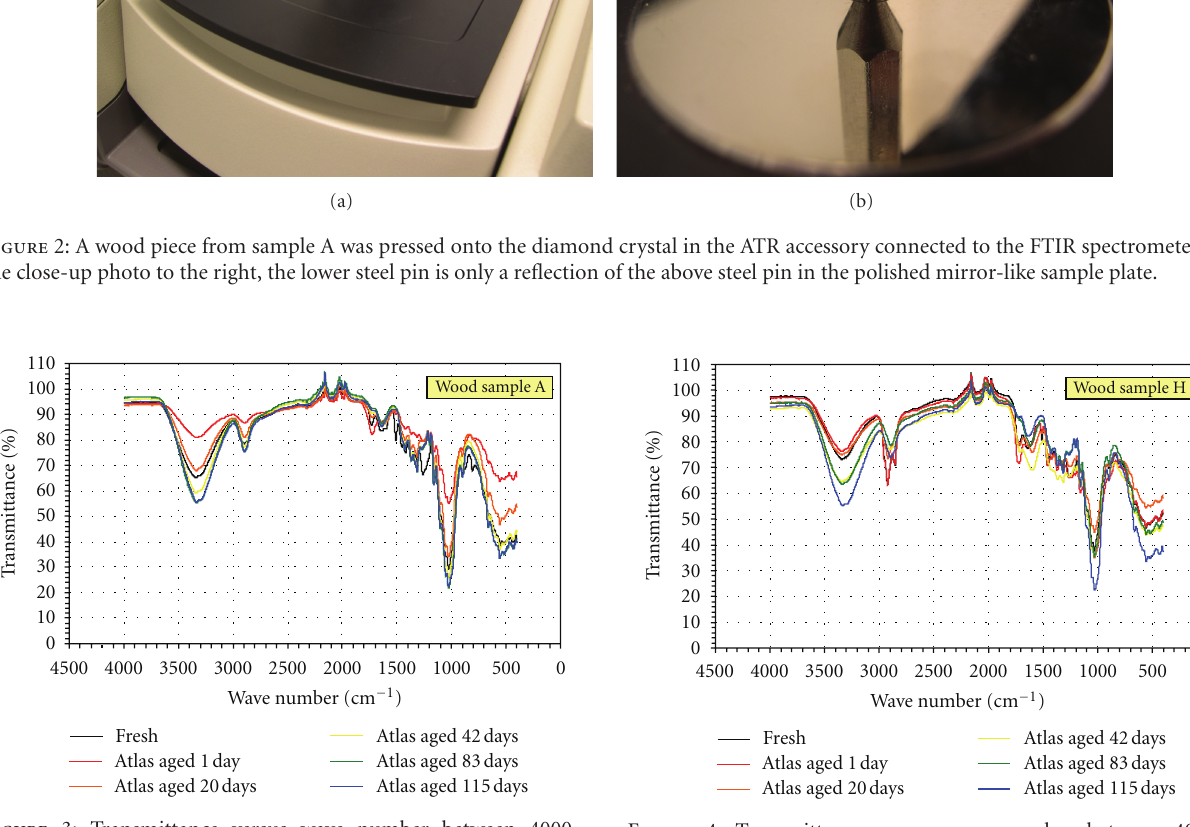
Figure 4: Transmittance versus wave number between 4000– 400 cm − 1 for wood sample H during accelerated ageing in an Atlas Solar